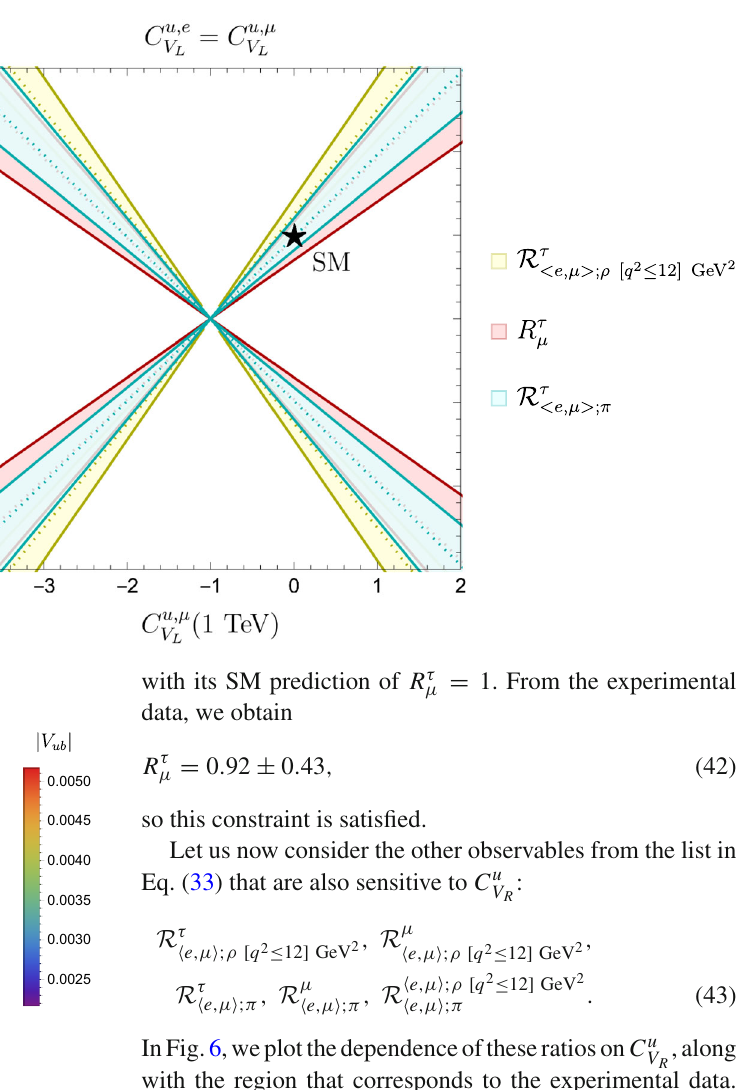
Fig. 4 Allowedregion from R τ μ inthe C u of | V ub | indicated along the central values of the